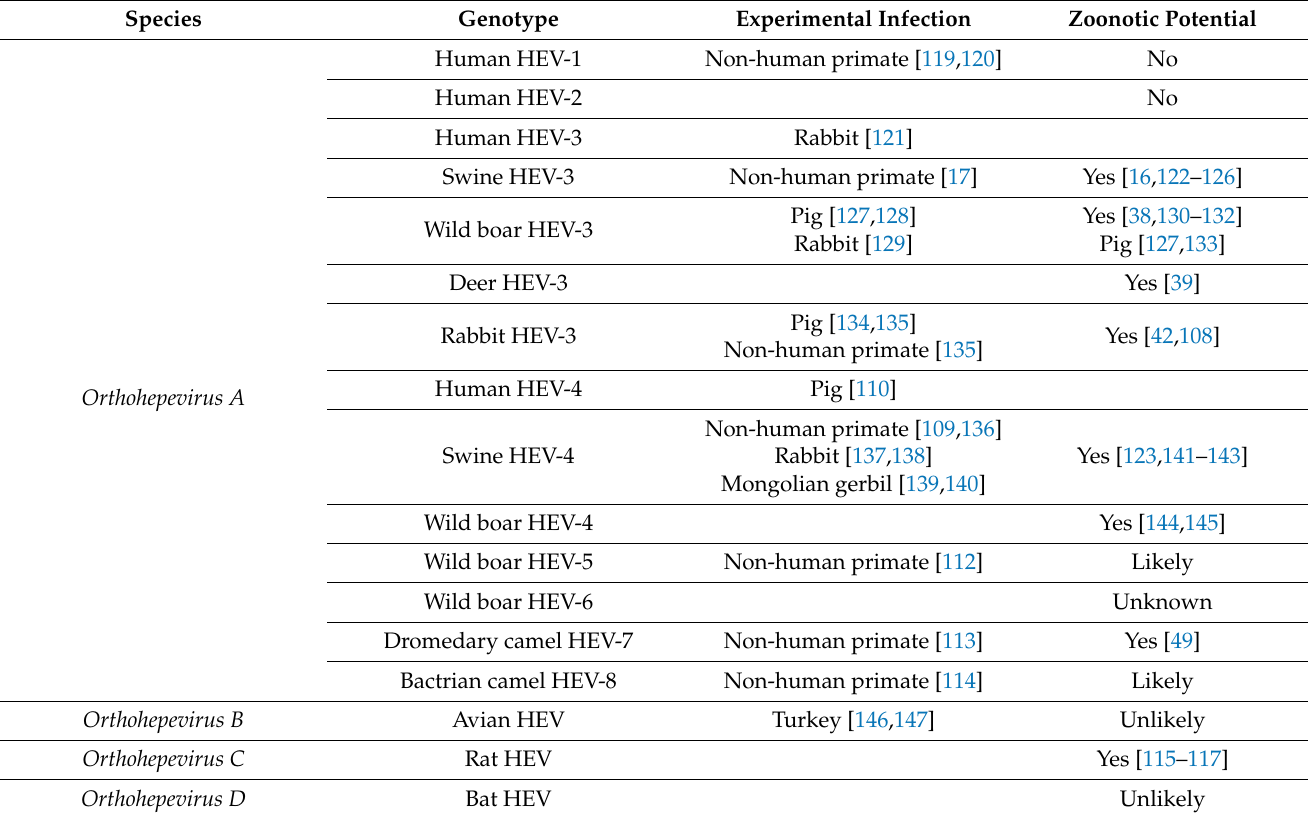
Table 1. Reported cross-species transmission of genus